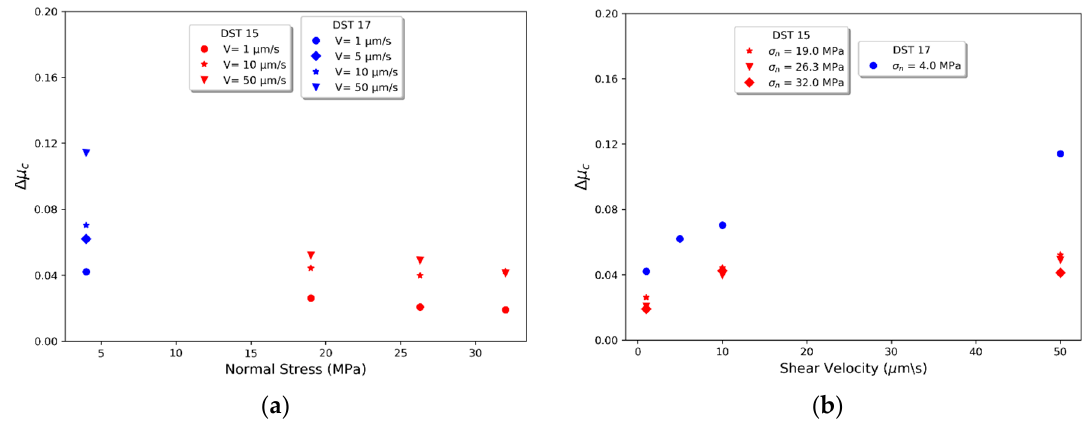
Figure 10. Frictional relaxation ( Δ μ c ) against normal stress ( a ) and shear velocity ( b ) for Draupne specimens. Frictional relaxation decreases with increasing normal stress, but increases with increasing shear velocity before holding.